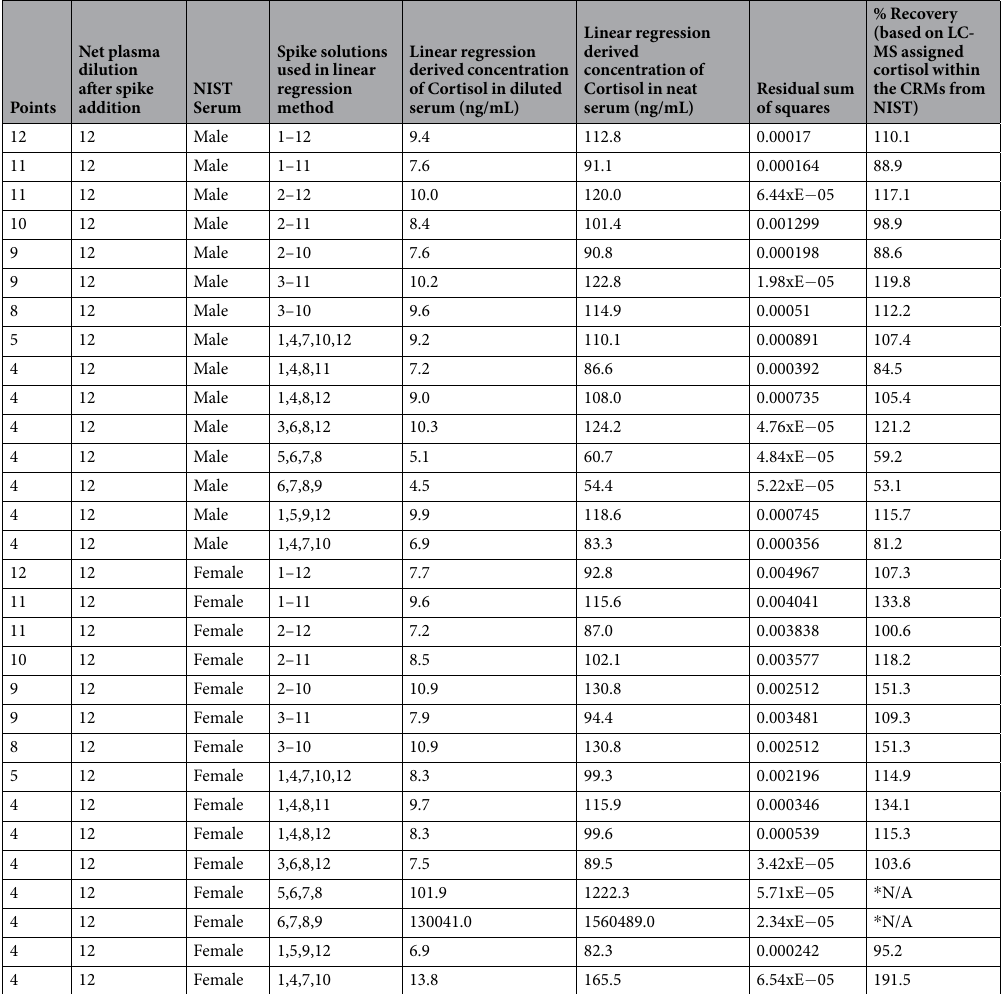
Table 2. Linear regression derived cortisol concentrations and recoveries determined using different combinations of the 11-spike concentrations of the male and female test sera. The residual sum of squares is the parameter minimised in a least squares linear regression, and is the sum of the squared difference between observed and fitted values. * N/A denotes that the recovery determined by this approach was ≥ 200%, and that the combination of data points used to derive the endogenous analyte concentration was